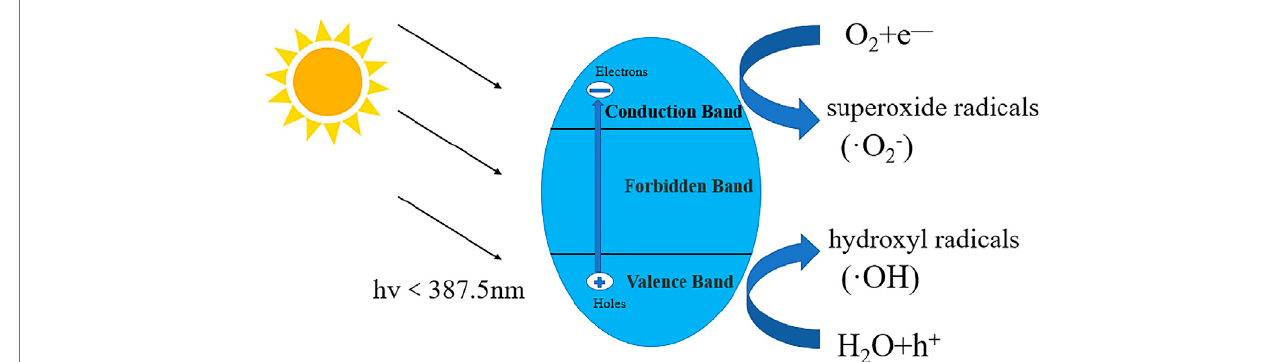
FIGURE 2 | Reaction principle diagram of titanium dioxide catalyst